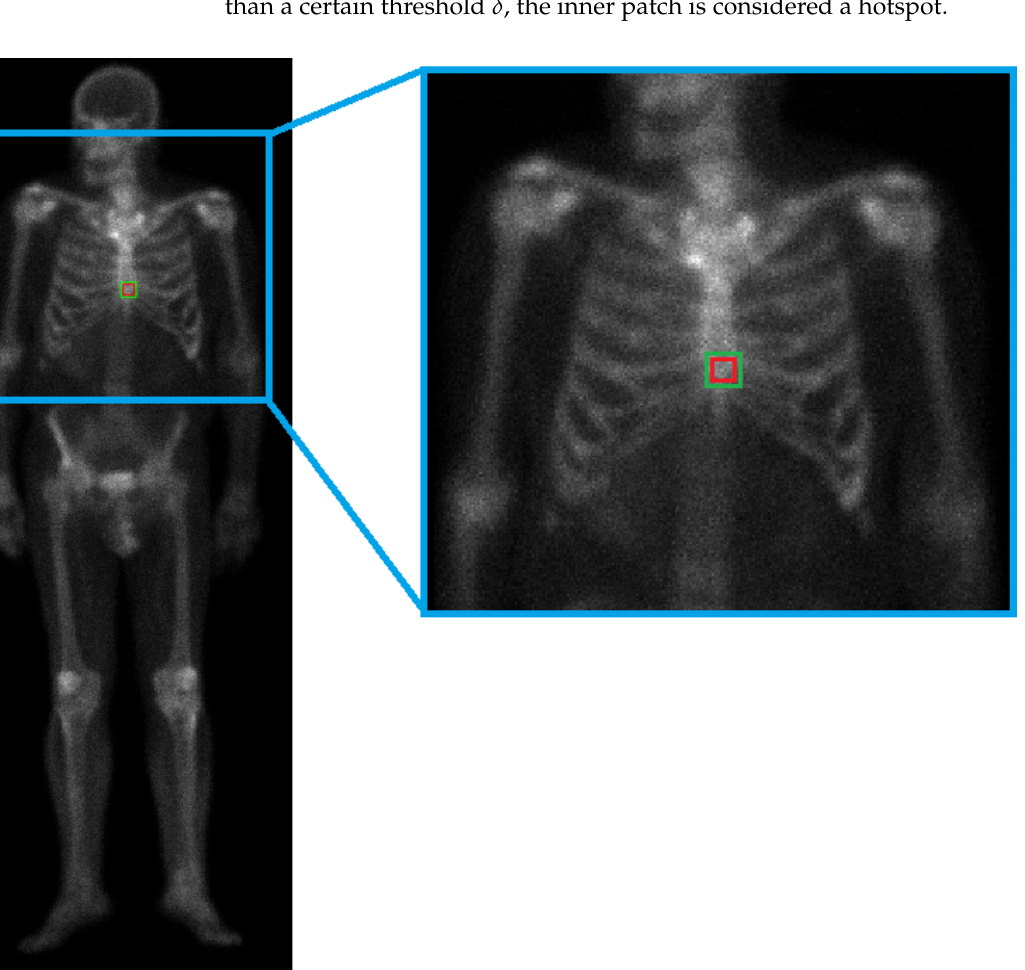
Figure 3. Detection illustration. Note that for illustration purposes, only one region is being tested in the current image. In the full detection algorithm, all of the regions within the mask are